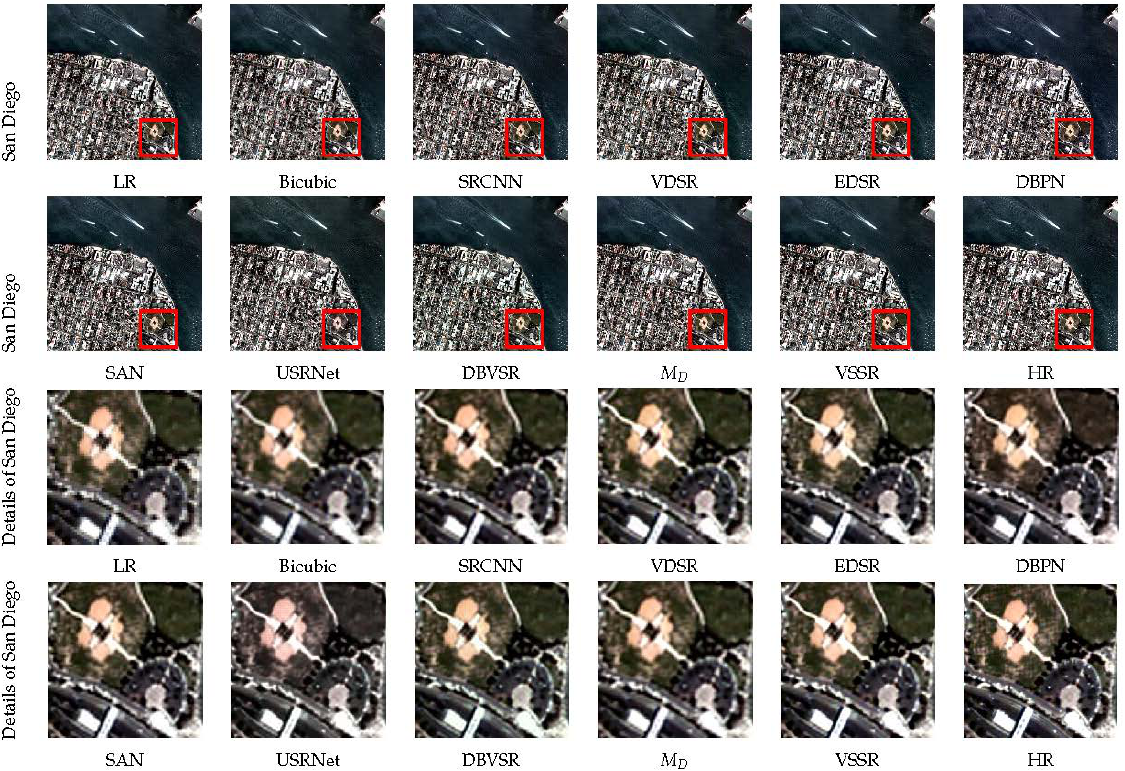
Figure 8. Reconstruction results on the third frame of San Diego (Jilin-1 data) by the scale factor of ×